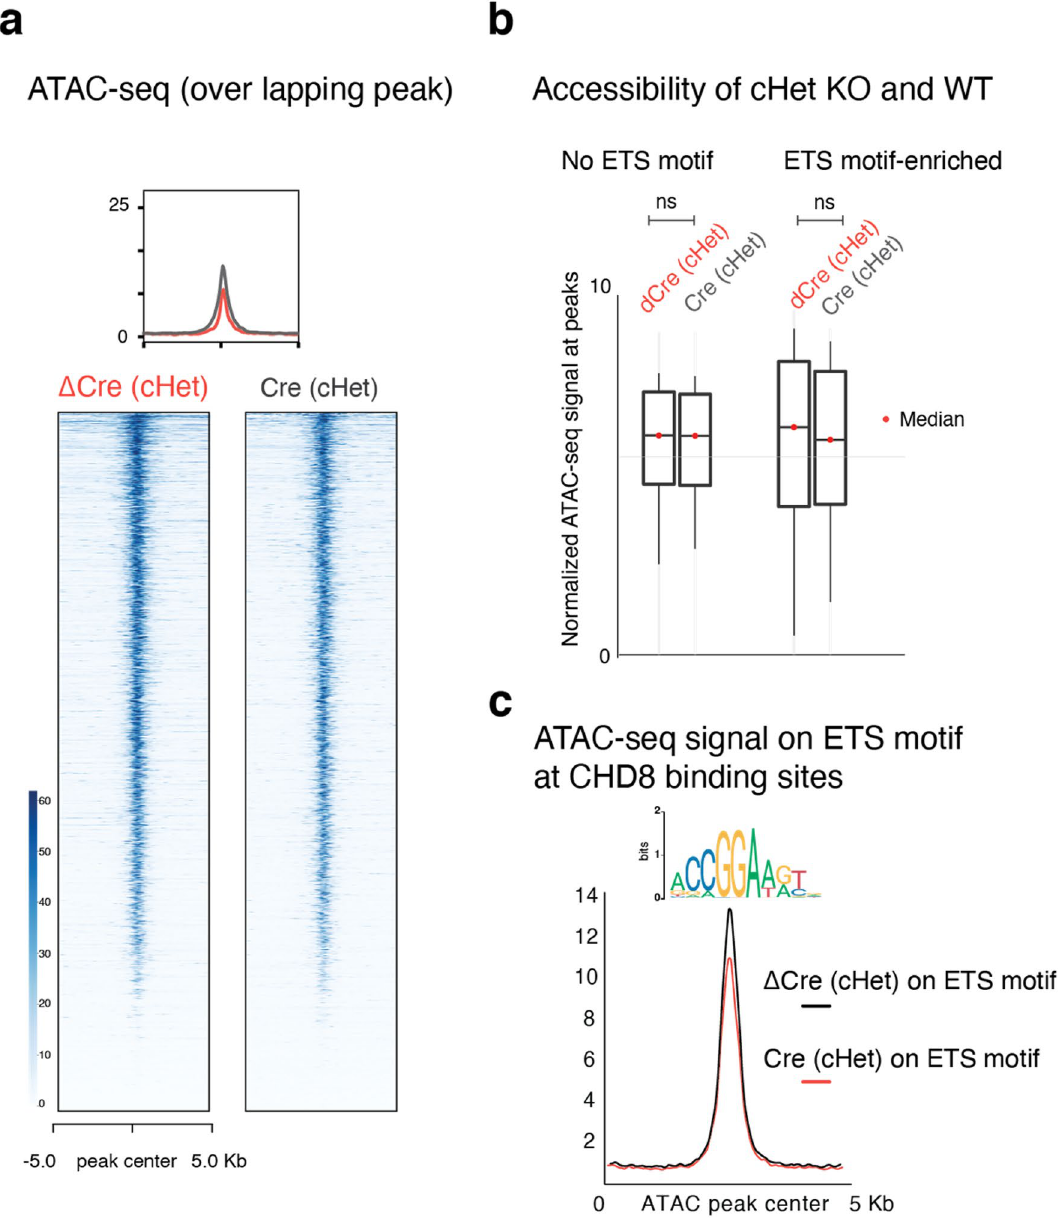
Figure 16. Comparison of ATAC-Seq results between heterozygous CHD8 knockout and WT neurons. ( a ) Heatmaps depicts normalized ATAC-seq signal across the overlapping peaks in wild type and heterozygous CHD8 knockout neurons. ( b ) Boxplots of chromatin accessibility at ETS motif factor sites in wild type and heterozygous CHD8 knockout neurons (ATAC peaks with more than one ETS motifs within each peak included in this analysis). The p-value is calculated with a non-parametric two-sided KS-test to compare the distribution of signals across the ATAC-seq peaks between the samples. ( c ) The enrichment plot of ATAC-seq signal from wild type and heterozygous CHD8 knockout neurons at selected sites that overlap with CHD8 binding in neurons and also carrying ETS factor motif